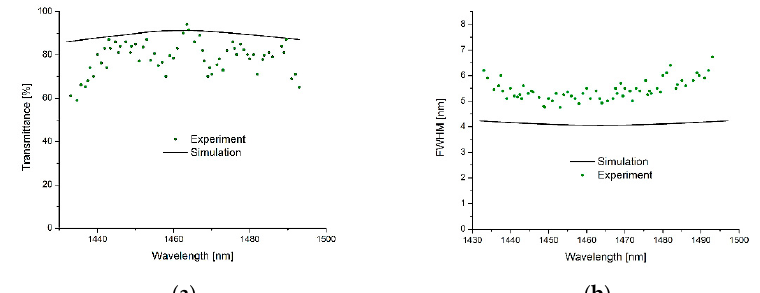
Figure 9. ( a ) Comparison of measured maximum transmission (symbols) of the filter lines of an FP filter array for the NIR spectral range with simulated data (full lines). ( b ) Comparison of measured FWHM (symbols) and simulated FWHM (full lines) of the same FP filter array. The corresponding Transfer Matrix simulations include experimental data for spectral absorption and spectral dispersion. Reproduced with permission from [35] © Springer Applied Nanoscience, 2016.